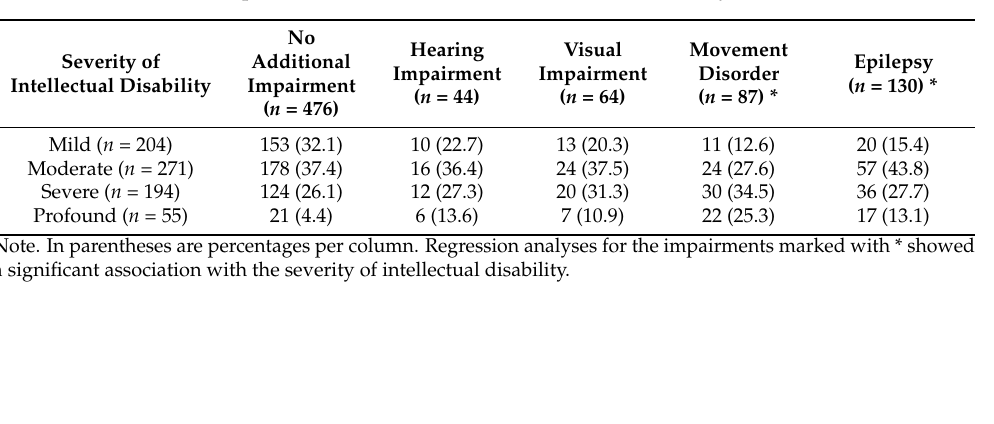
Table 1. The Different Impairments and Severities of Intellectual